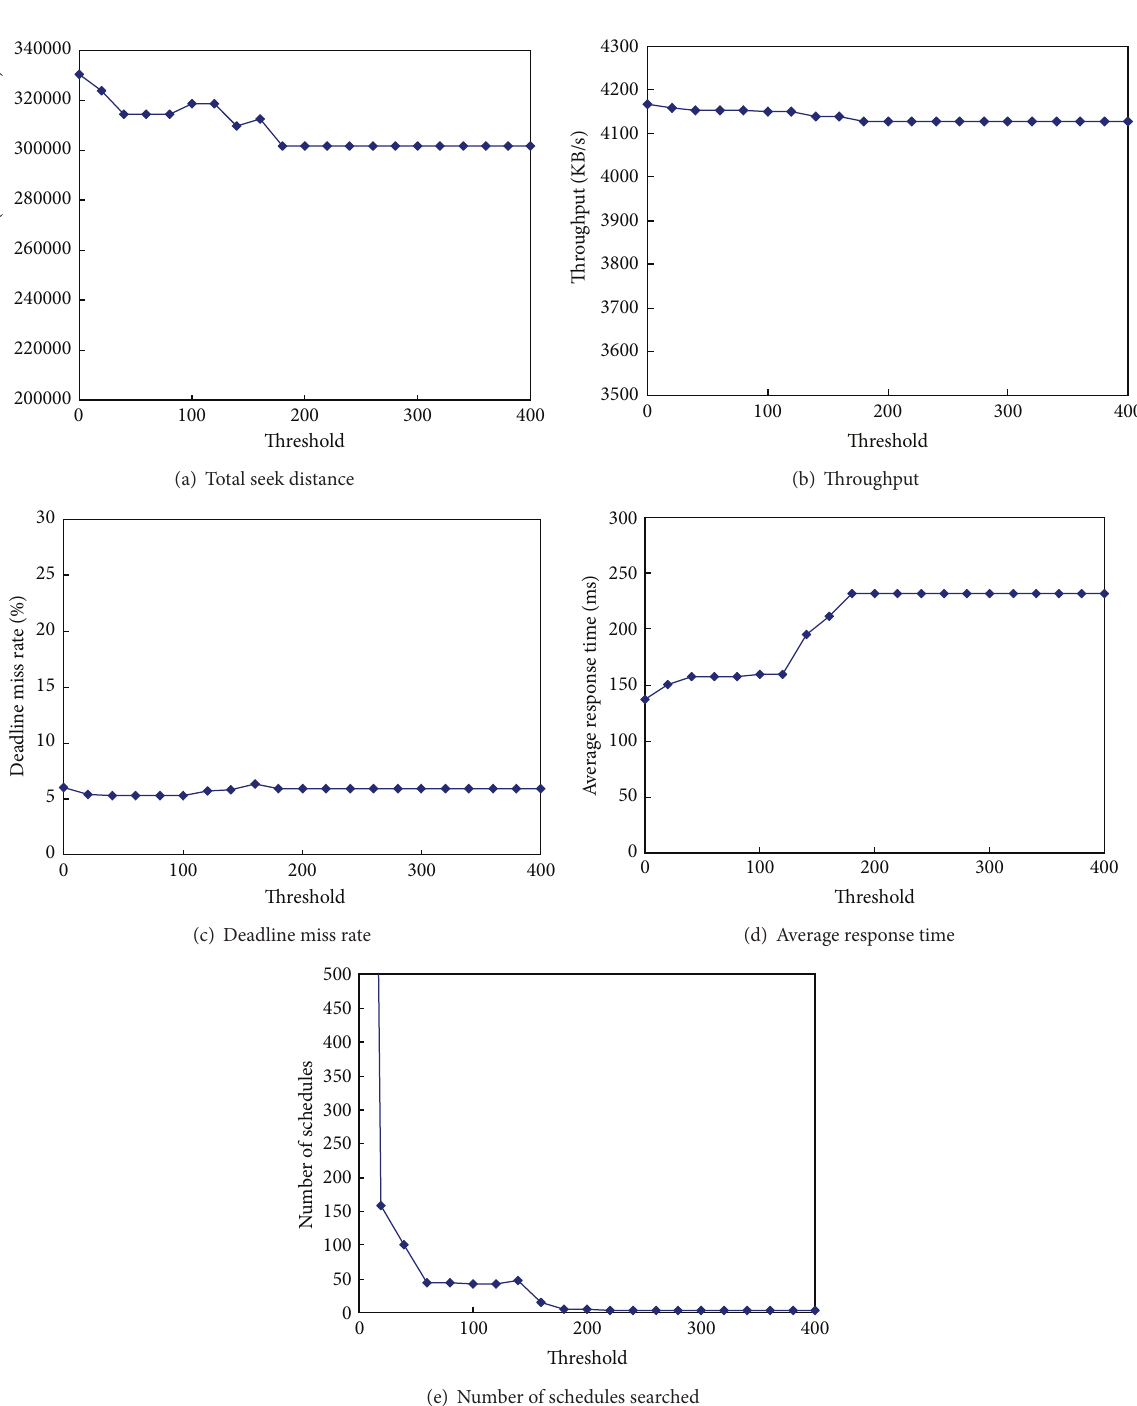
Figure 4: The effect of grouping in